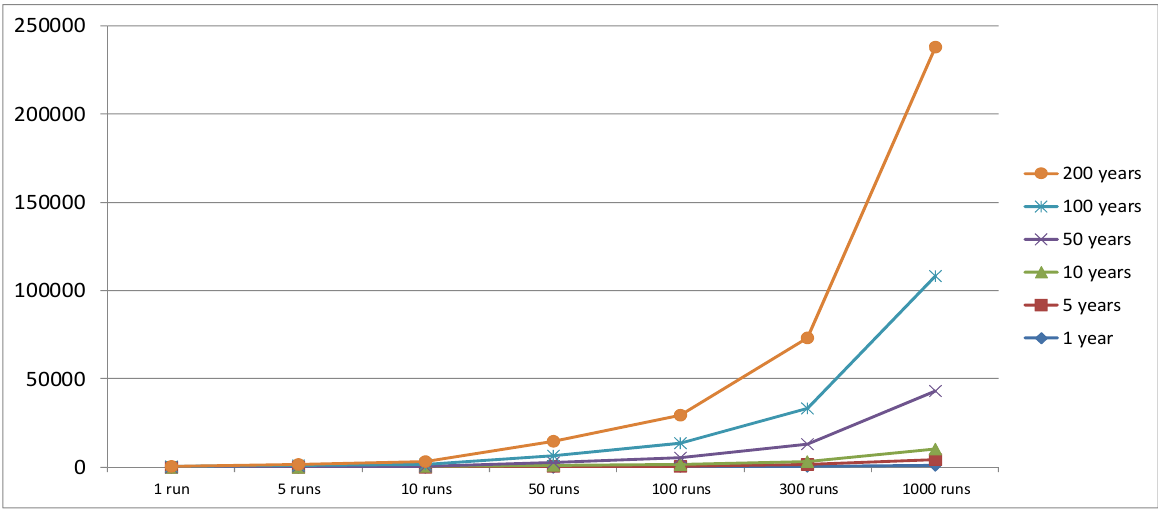
Figure 1. ModelE data